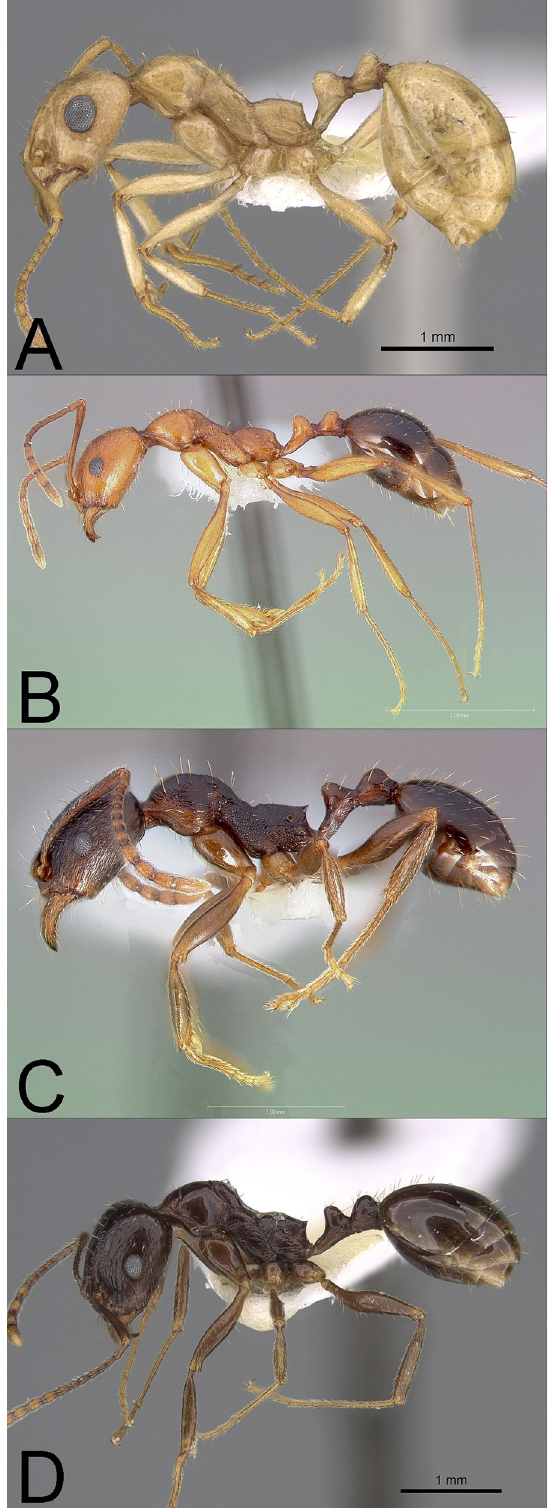
Fig 2. Profile photographs of pale (A) and dark species (B-D) (see text) of Aphaenogaster (subfamily Myrmicinae) examined in this study: ( A ) A . megommata (CASENT0923367), ( B ) A . boulderensis (CASENT0005722), ( C ) A .